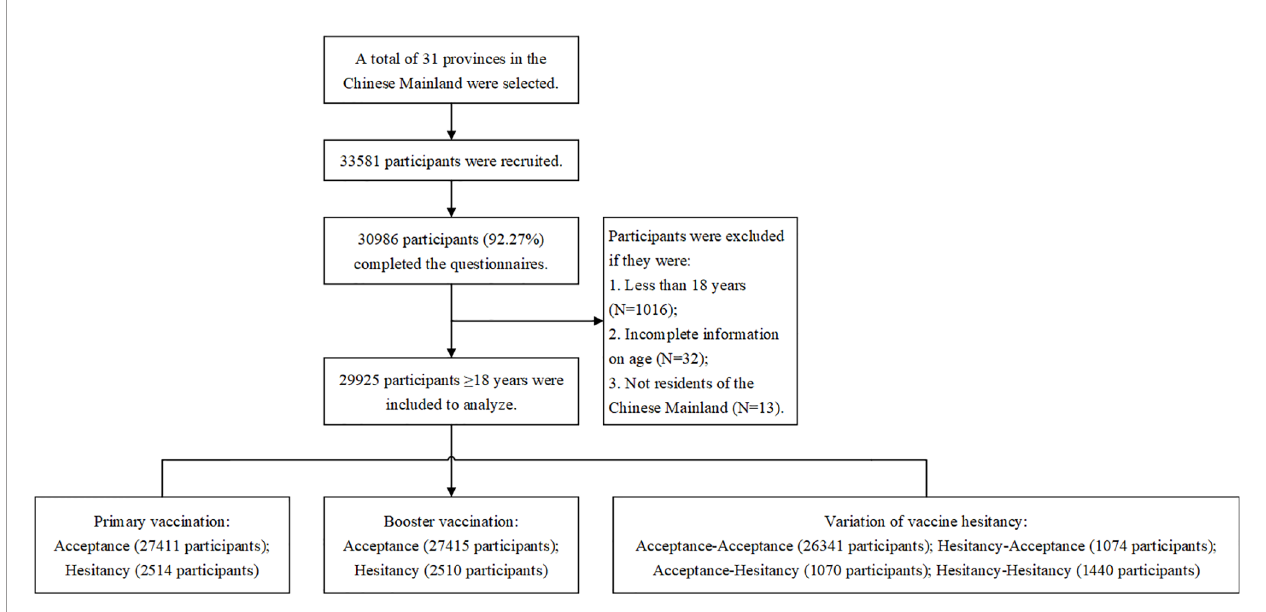
FIGURE 1 | The fl owchart of participant